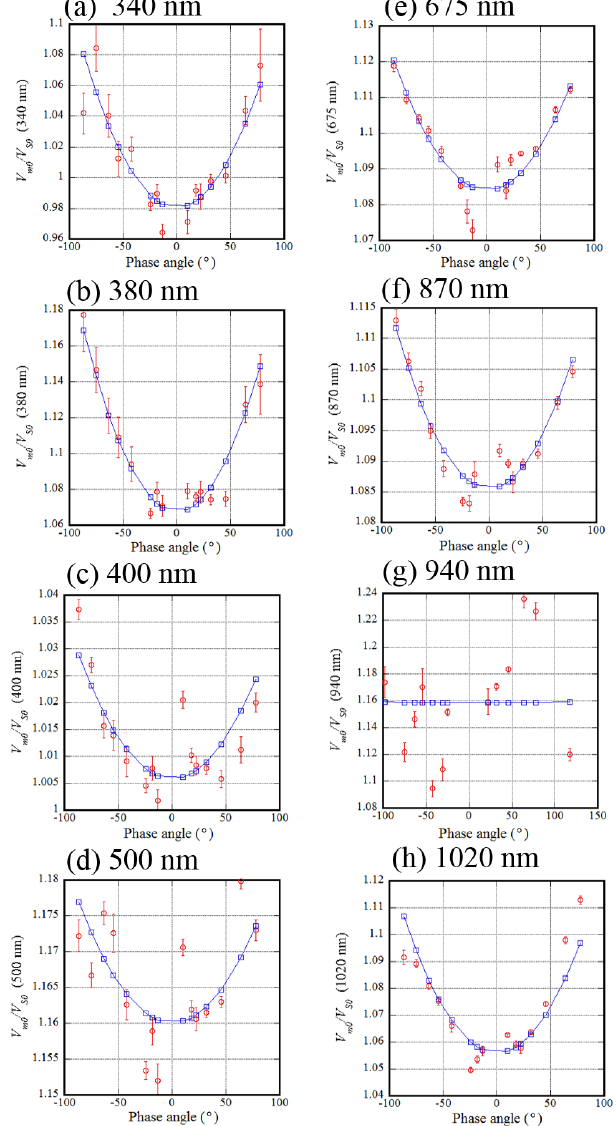
Figure 5. Relationship between phase angle and reflectance correc- tion factor C = V m 0 /V S 0 in the visible and near-infrared region. A regression curve ( C = A c · g 2 + B c , g : phase angle) was also plotted.